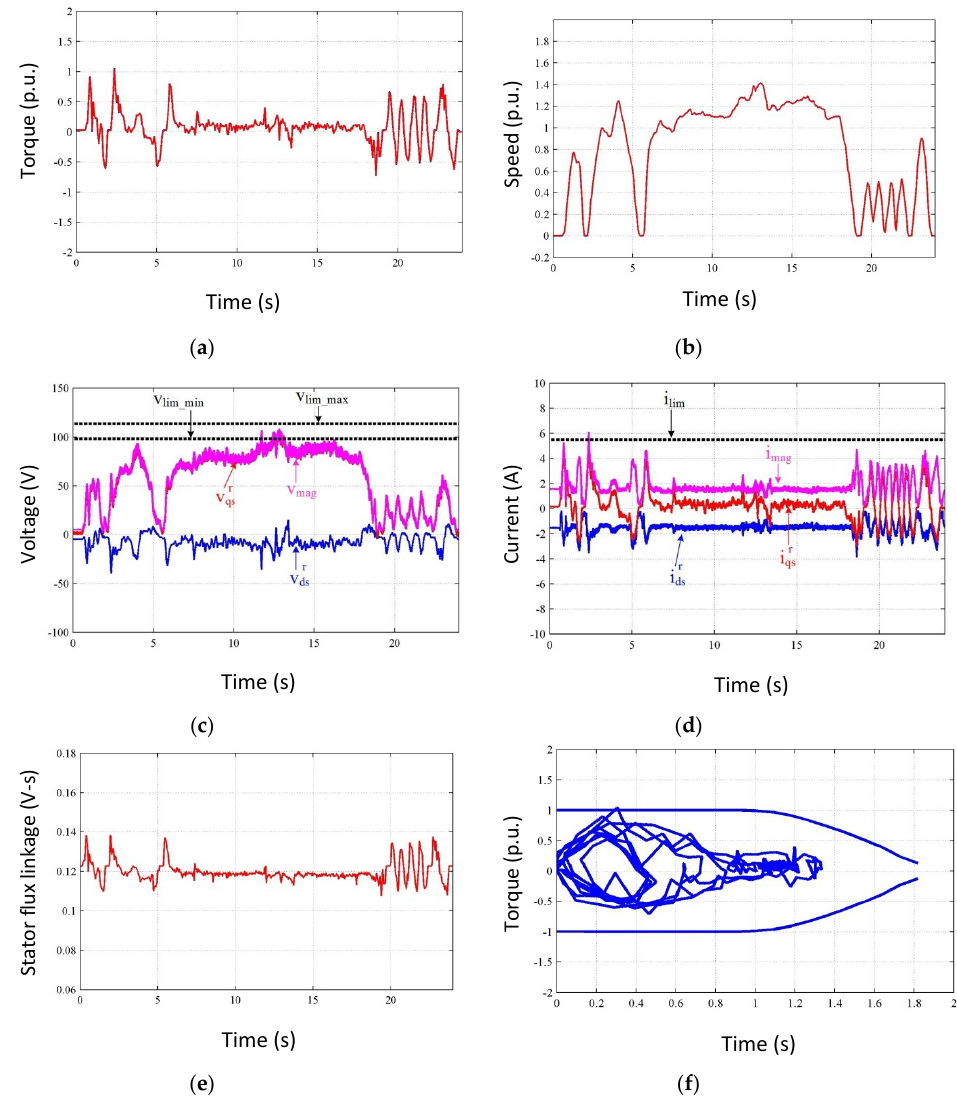
Figure 13. Experimental results of dynamics of the DB-DTFC IPMSM drive along the US06 SFTP driving cycle. Operating conditions: f SW = 10 (kHz) and V dc = 170 (V). ( a ) Torque; ( b ) Speed; ( c ) Voltage; ( d ) Current; ( e ) Stator flux linkage; ( f ) Torque-speed.